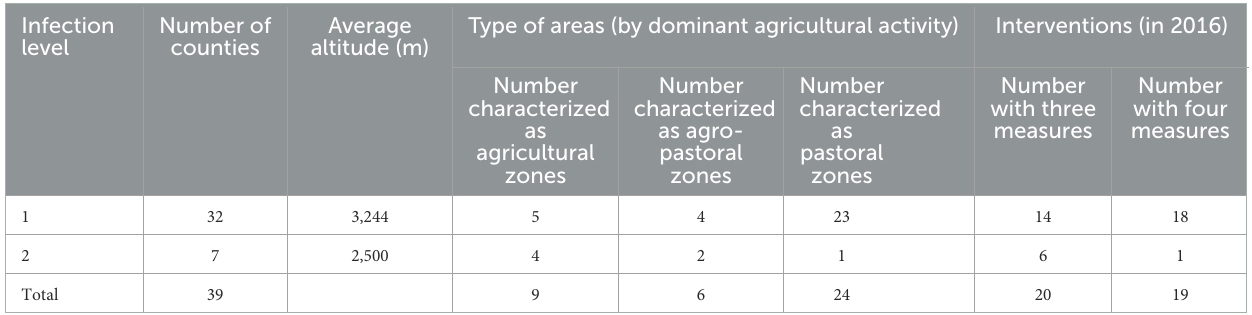
TABLE 1 Characteristics of sampled counties in